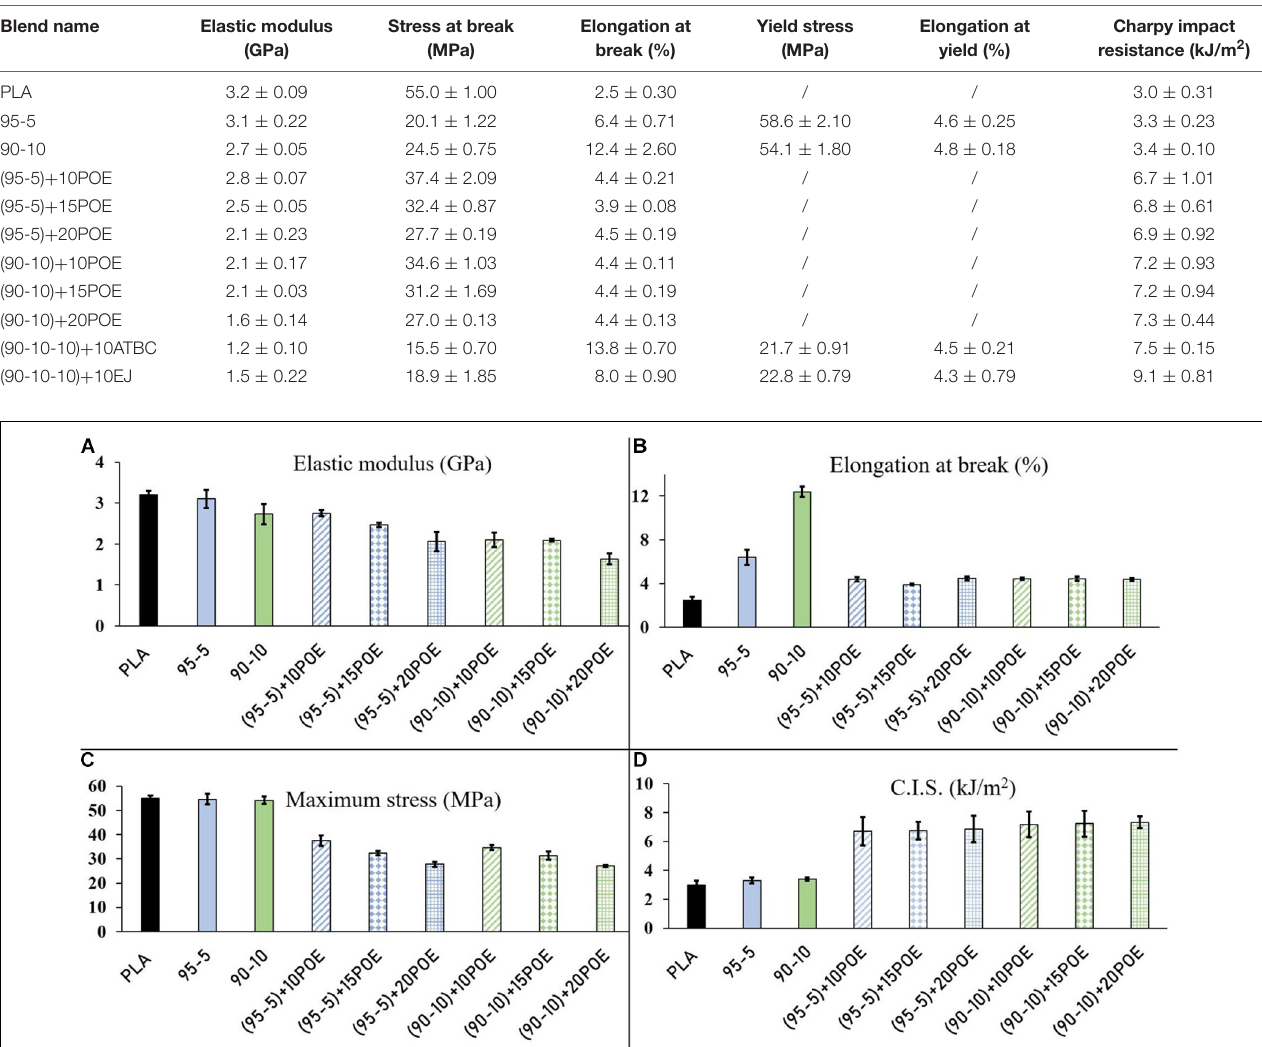
TABLE 3 | Mechanical results of tensile tests with experimental deviation.